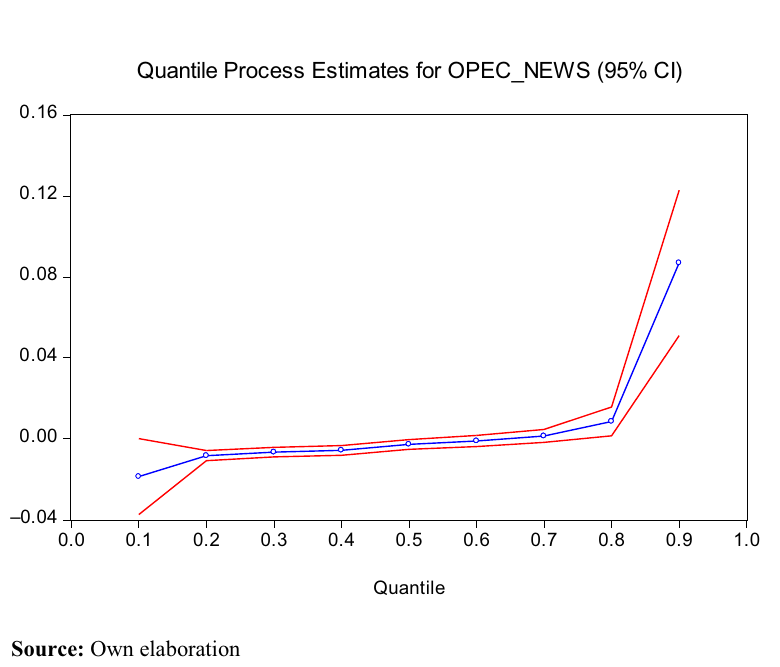
Figure 14. The quantile process estimates for OPEC news on the crude oil WTI futures over the period from April 01, 2013 to June 30,